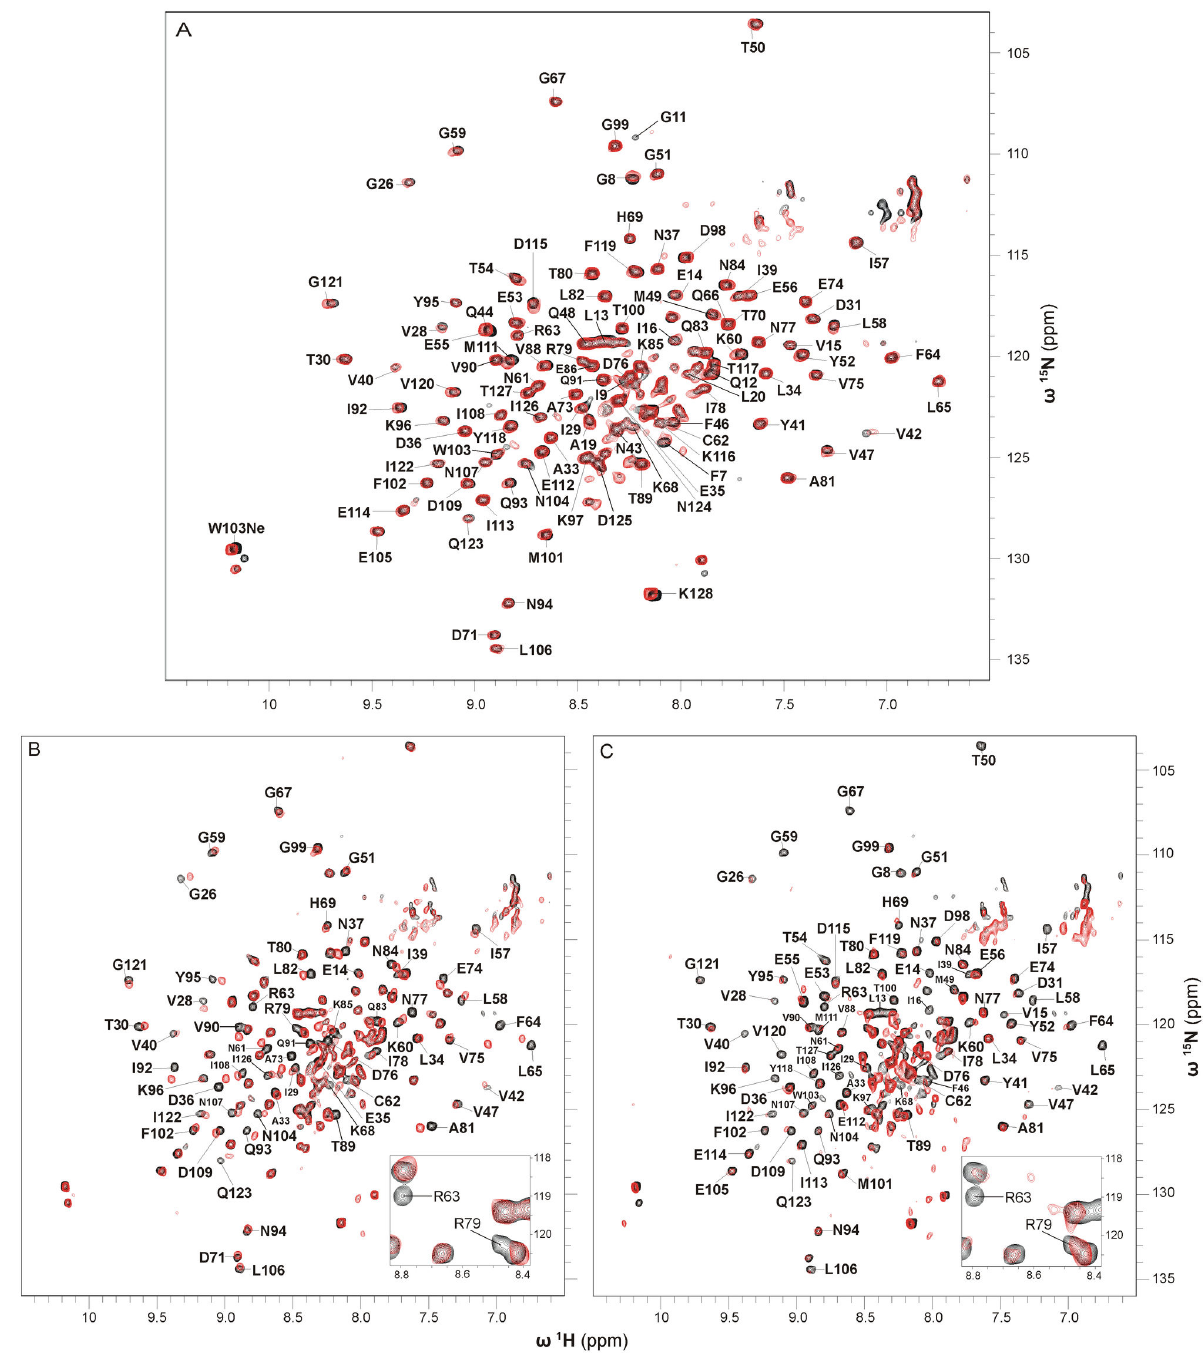
Figure 5. Superposition of 1 H- 15 N-TROSY spectra of E.coli-YLOV and its reconstituted variants. (A) 1 H- 15 N-TROSY spectra of E.coli-YLOV (black) and FMN-YLOV (red). All sequentially assigned resonances of E.coli-YLOV are labeled with residue type and sequence position. (B) 1 H- 15 N-TROSY spectra of FMN-YLOV (black) and RF-YLOV (red). Sequentially assigned resonances of FMN-YLOV possessing different chemical shifts in RF-YLOV are labeled. Note that the signal from T 80 is not shifted indicating that the chemical environment of this residue is the same in both proteins. (C) 1 H- 15 N-TROSY spectra of FMN-YLOV (black) and FAD- YLOV (red). All both evaluable and sequentially assigned resonances of FMN-YLOV that are either changed in terms of intensity, shifted or unaffected in FAD-YLOV are labeled.The insets in A and B show a close up of the region of chemical shifts involving R 63 and R 79 . All spectra were recorded from uniformly 15 N-labeled samples. doi: 10.1371/journal.pone.0081268.g005 PLOS ONE |